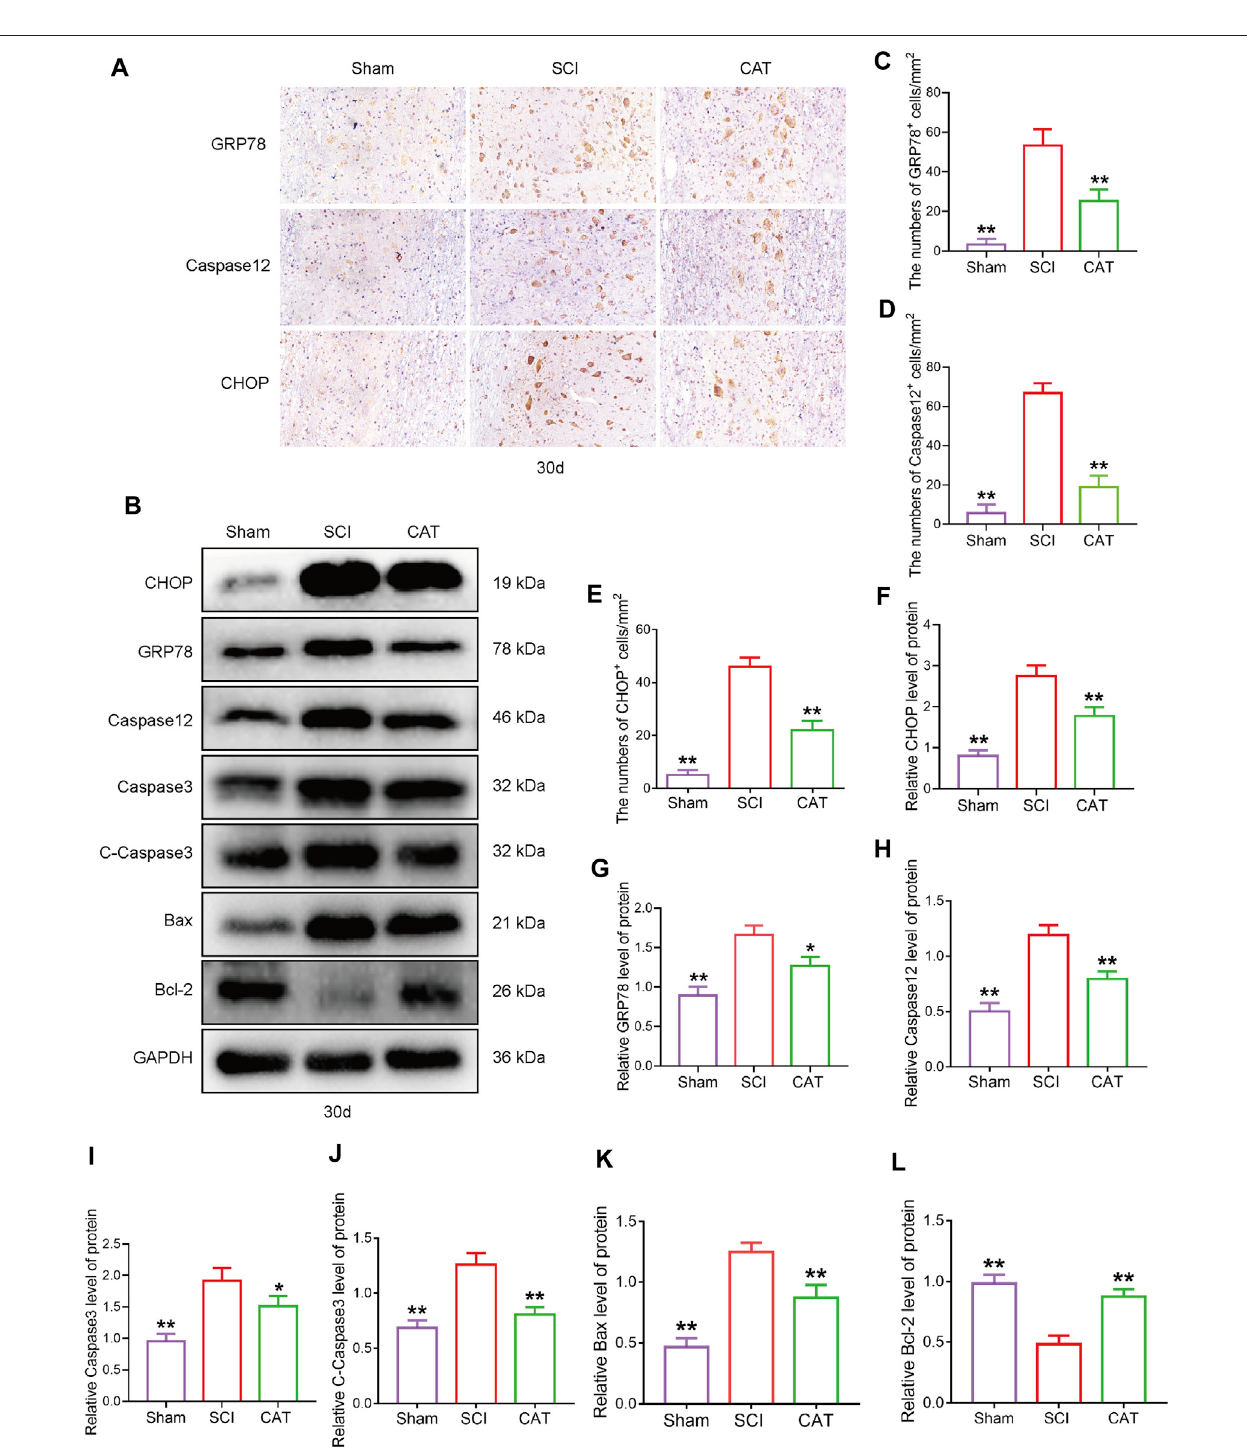
FIGURE4| CATinhibitsERstress-inducedapoptosisinSCIrats. (A) ImmunohistochemicaltestshowingGRP78,CHOP,andCaspase-12expressionintheSham group, SCI group, and CAT group. (B) Western blotanalysisshowing the protein expression ofCHOP,GPR78, Caspase12, Caspase3, C-Caspase3, Bax, and Bcl-2 in the Sham group, SCI group, and CAT group. GAPDH is used as a loading control. (C – E) Analysis of optical density signals in immunostained cells. (F – L) Quantitative analysis of CHOP, GPR78, Caspase12, Caspase3, C-Caspase3, Bax, and Bcl-2 protein expression. Student ’ s t test was used to analyze Immunohistochemical and Western blot results. “ * ” represents p < 0.05, “ ** ” p < 0.01 versus the SCI group with statistical signi fi cance. Data are represented as mean ± SD ( n = 3).